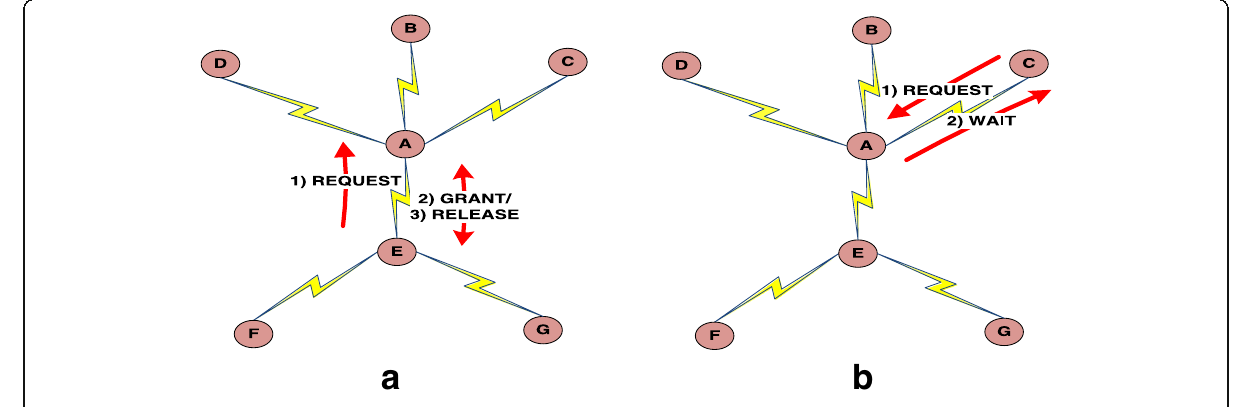
Fig. 5 a AEH-MAC slot reservation request ( b ) AEH-MAC WAIT